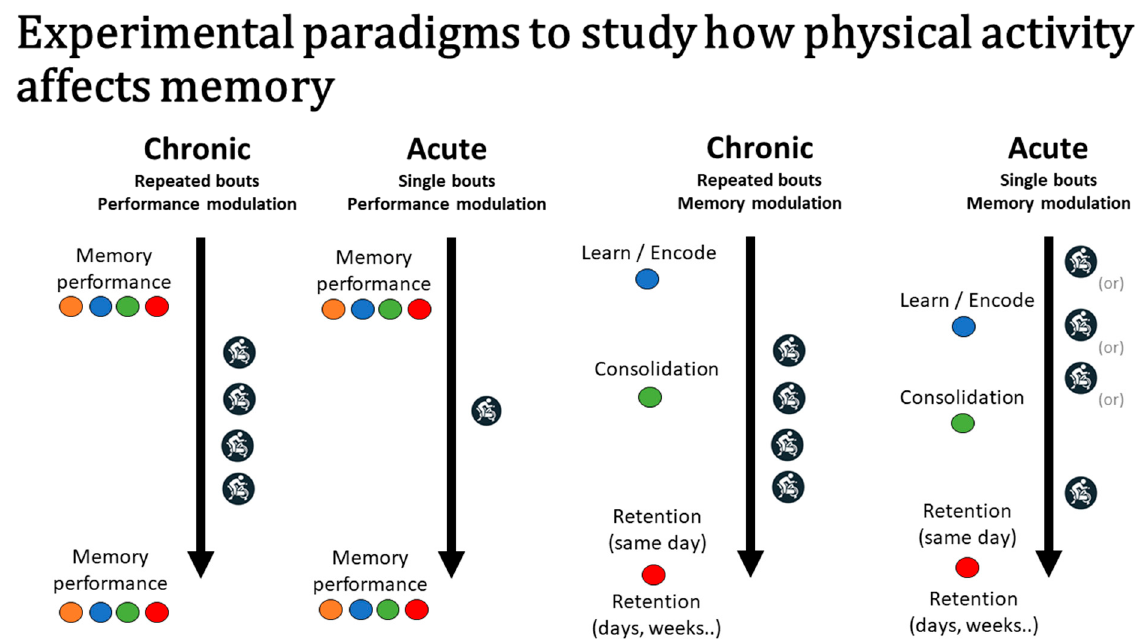
Figure 1. Illustration of the use of acute and chronic exercise designs to evaluate the effects of exercise on memory and across different phases of memory. Performance modulation refers to changes in memory performance without focusing on a specific memory phase. In contrast, memory modulation refers to evaluating how a long-term memory is influenced from modulating a particular phase of memory. For performance modulation, exercise, either repeated bouts (chronic exercise) or a single bout (acute exercise), would occur between a memory test that included both exposure and retrieval. For memory modulation, repeated bouts of exercise (chronic exercise) would typically occur during the consolidation period, whereas, for acute exercise, the bout of exercise may occur at any phase of memory. Blue circles represent encoding; green, consolidation; and red, retrieval. Orange circles represent short-term memory (inclusive of working memory).